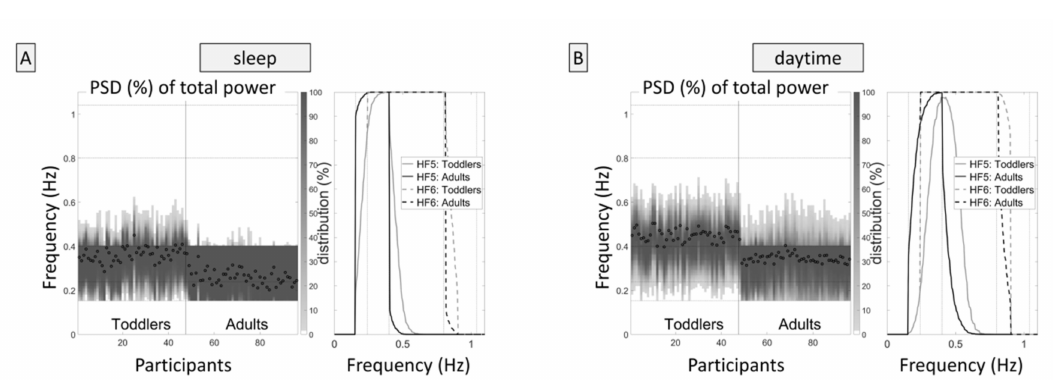
Figure 1. Dynamically adjusted frequency bands. The figure on the left side shows the distribution of the frequency ranges for each participant during sleep. ( A ), each column represents one participant. The shade of the columns represents the percentage of the power spectral density (PSD) in the respective frequency (percentage of the respective participant’s total power). The dots represent the respiration frequency of each participant (the arithmetic mean of all dots for toddlers equals the value given in Table 2, i.e., 0.36 Hz or 21.7 min − 1 ). ( B ) shows the percentages of participants in whom variability in the respective frequencies was continuously present, that is, in all 180 s segments over the entire recording period, displayed for HF5 and HF6. The figure illustrates how well (or poorly) the frequency bands captured the actual heart rate variability in adults and toddlers: In the majority of adults, but not in toddlers, the dominant frequencies are in the recommended frequency range for short-term heart rate variability (HRV, 0.15–0.40 Hz). The right figure shows the dynamic frequency band adaptation for the